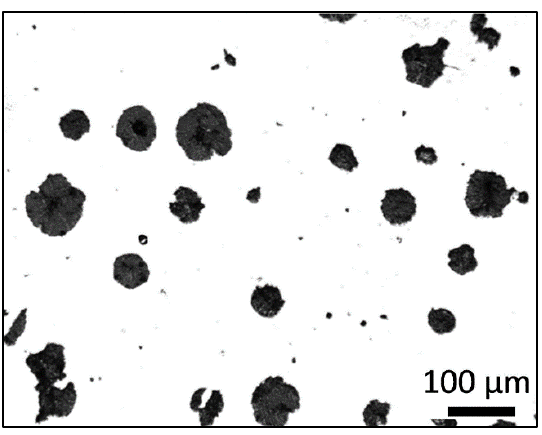
Figure 3. Optical micrograph of the SGI-3 specimen; thickness: 50 mm.